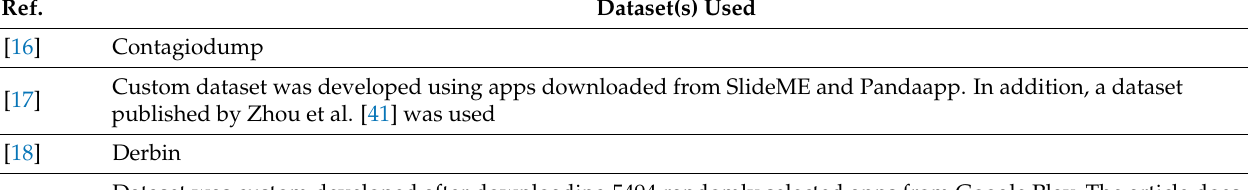
Table 4. Datasets used in primary